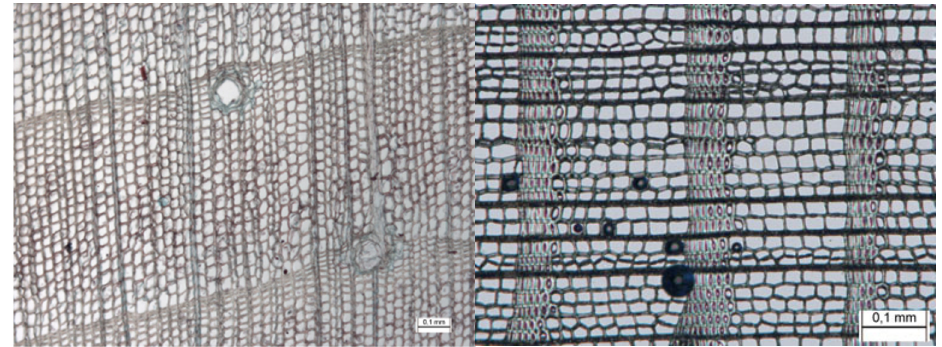
Figure 11. On the left is a cross-section of Swiss stone pinewood; on the right is a cross-section of Larchwood. The difference in the characteristics of the latewood between the two timbers is evident: very thin in the first case and thick in the latter.